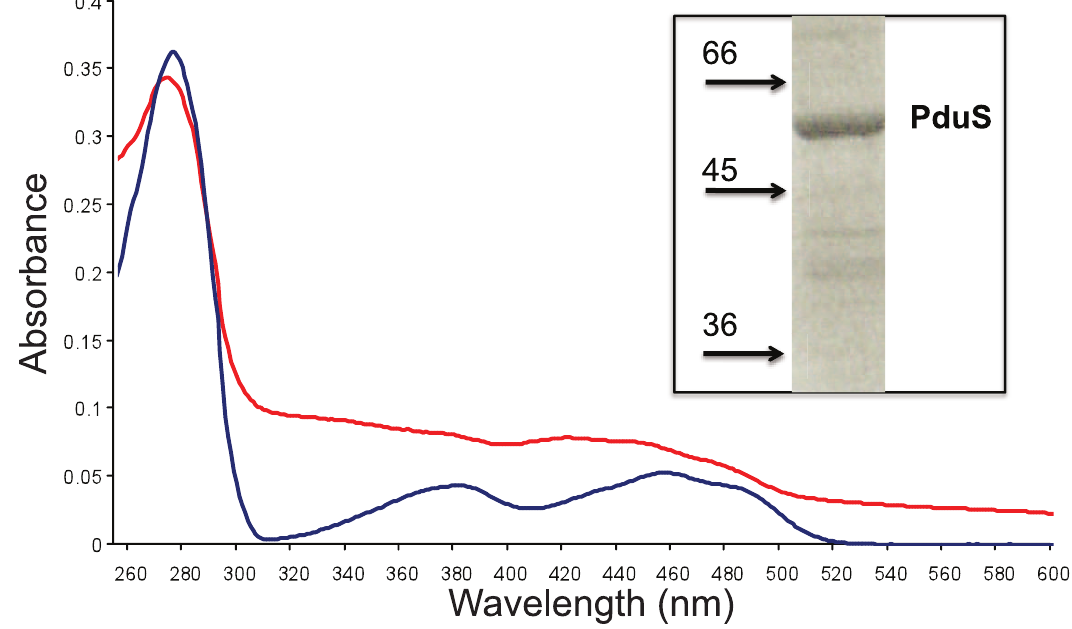
Figure 2. UV-visible spectrum of purified PduS. The UV-visible spectrum of aerobically-purified PduS in 20 mM Tris-HCl (pH 8.0) in red is compared to that of aerobically purified PduS (in blue). The blue spectrum is consistent with that of a flavoprotein whereas the red spectrum has added features around the 420 nm region consistent with the presence of additional [Fe-S] centre(s). A gel of purified PduS is shown in the inset.